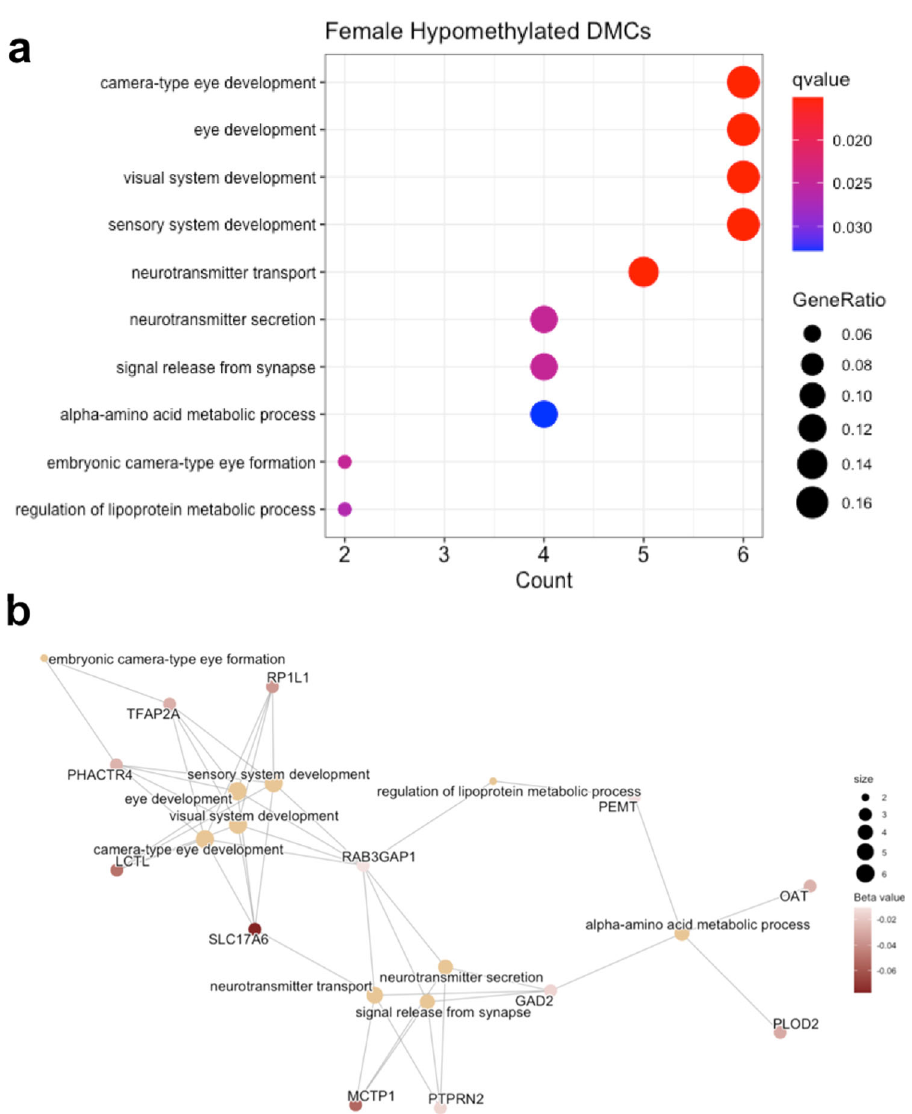
Fig. 5 GO Term enrichment dot plot and gene-concept network plot for female hypomethylated DMCs. a Female hypomethylated DMCs showed enrichment for 10 pathways, including neurotransmitter transport, neurotransmitter secretion, and signal release from synapse. The x -axis is the number of genes in each pathway, color is used to represent FDR q -value ( q -value), and size is used to represent GeneRatio, the ratio of differentially methylated genes in each GO term to the total number of genes input into the hypergeometric test. b Several differentially methylated genes were included in the enriched pathways, including PTPRN2 , which also showed differential DNA methylation at the region level in both males and females. The size of each node is used to represent the number of genes in each GO term, and color represents the magnitude of decrease in DNA methylation (beta value) for each annotated probe. Connections between genes and GO terms represent inclusion of the gene in that GO